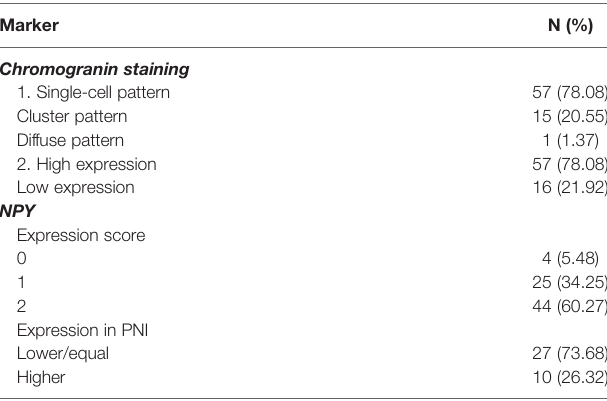
TABLE 3 | The summary of chromogranin and NPY expression results. Marker N (%) Chromogranin staining 1. Single-cell pattern